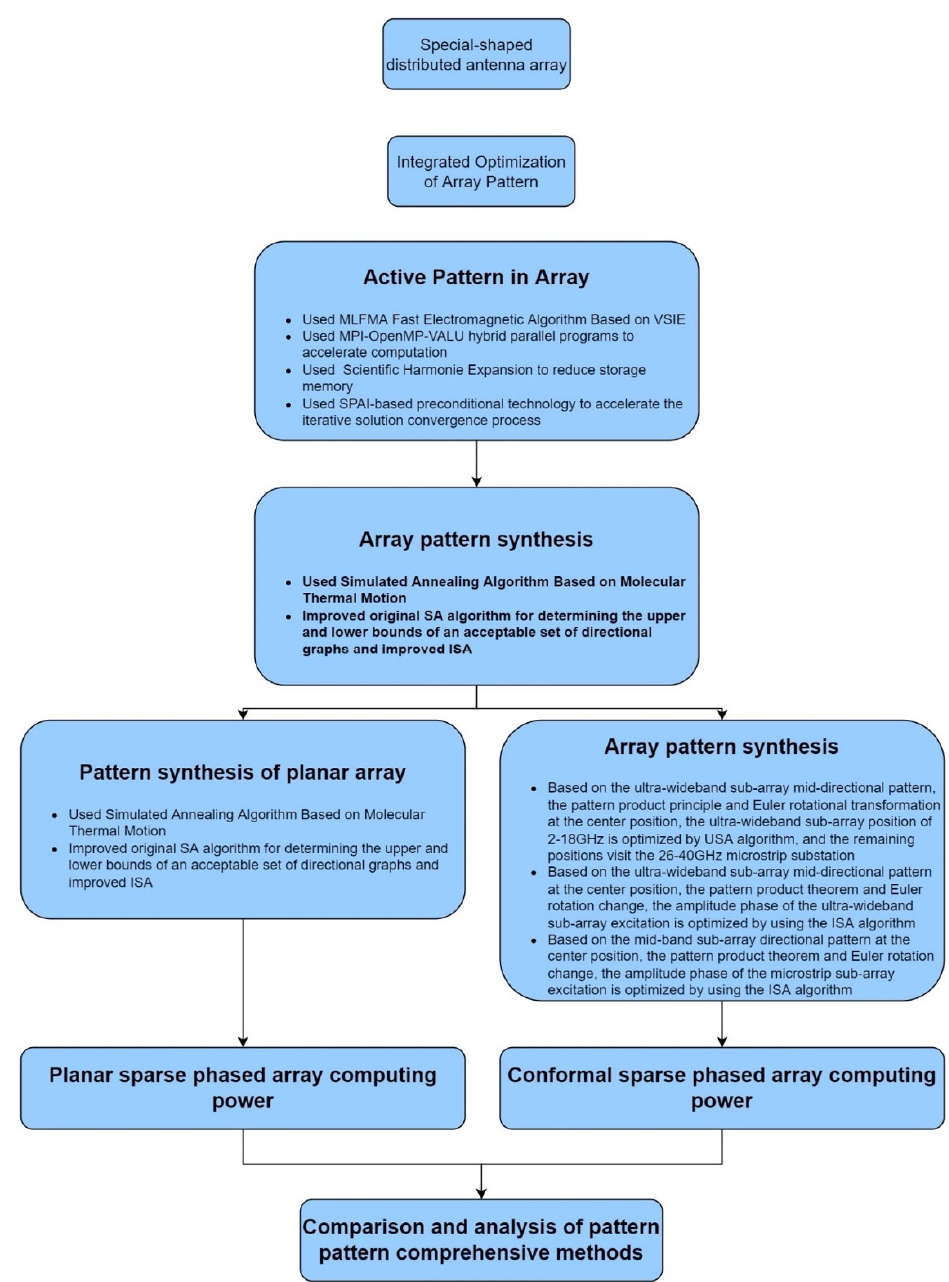
Figure 1. Optimization process diagram of calculation method.